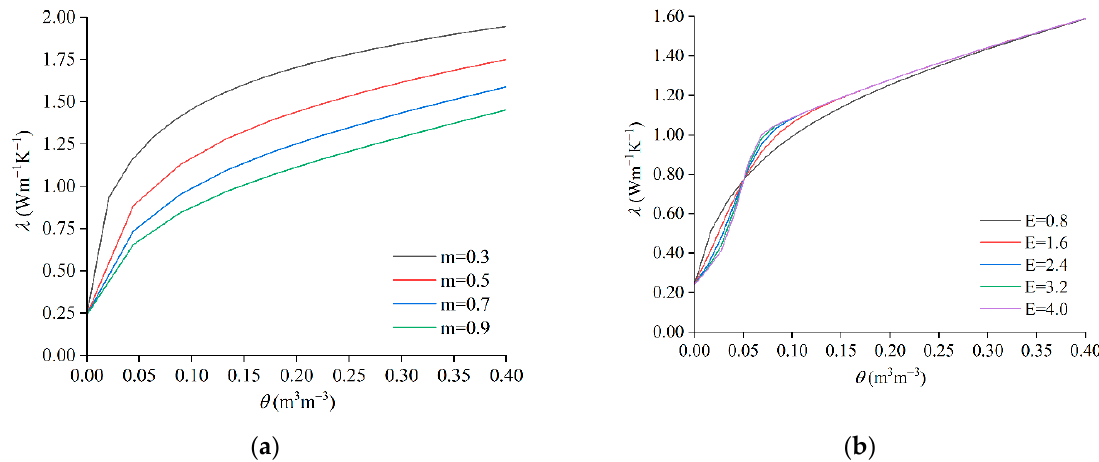
Figure 4. The influence of m and E values on the shape of the λ ~ θ curve, respectively. Figure ( a ) shows the influence of different values of m on the curve when E = 0.8 and Figure ( b ) shows the influence of different values of E on the curve when m = 0.7.